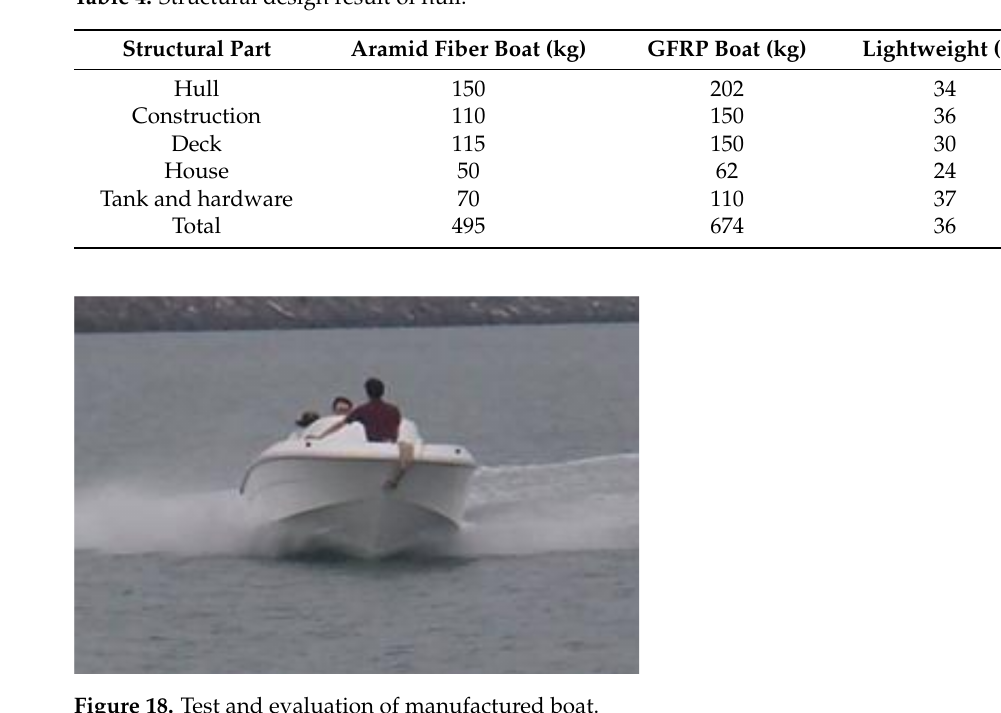
Figure 18. Test and evaluation of manufactured